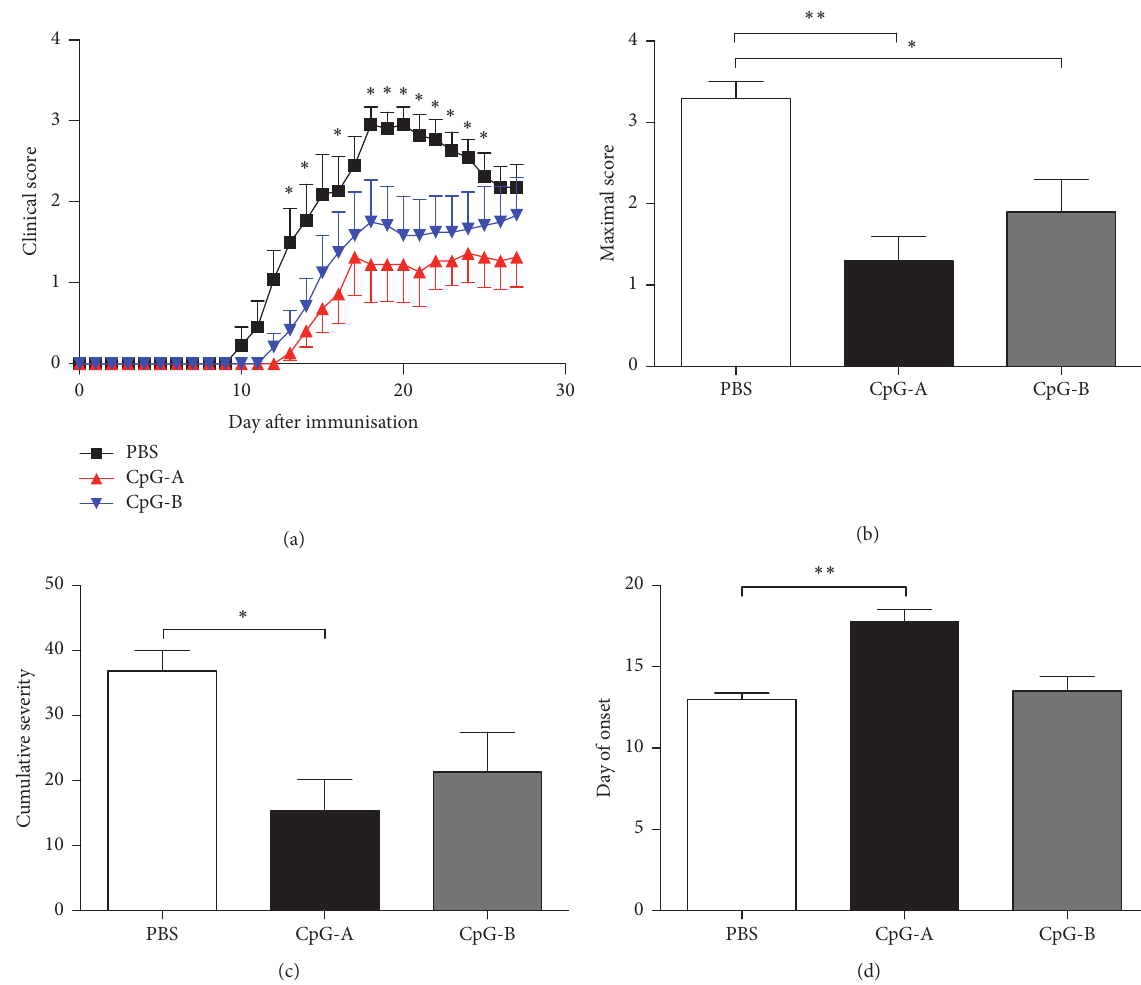
Figure 1: Effect of CpG-A and CpG-B on EAE. (a) Mice were i.p. treated with of CpG-A, CpG-B, or PBS on days 1, 3, and 5 p.i. Data are mean ± sem of daily scores, in one experiment representative of three independent experiments with 𝑛 = 7 mice per group. ∗ 𝑝 < 0.05 , (Mann–Whitney 𝑈 test). (b) Intraperitoneal treatment with CpG-A reduced EAE maximal and cumulative scores and delayed the onset (d) in C57BL/6 mice when compared to PBS-treated mice. Depicted are the means ± sem from three separate experiments ( 𝑛 = 7 per group). ∗ 𝑝 < 0.05 , by Kruskal-Wallis test followed by dunnett’s test as post hoc. ∗∗ 𝑝 < 0.01